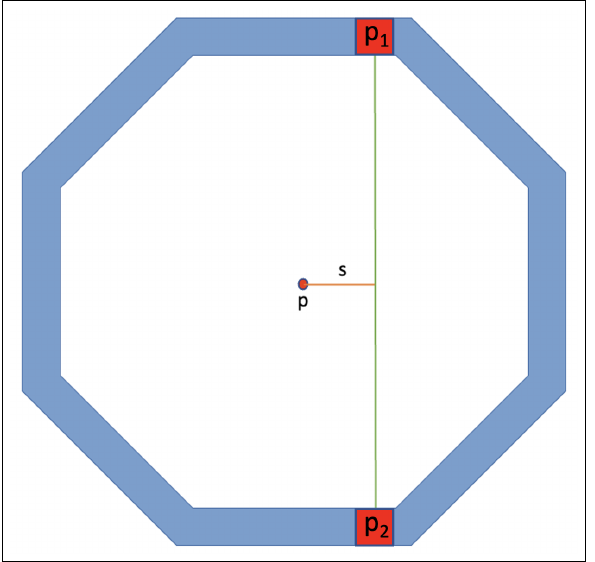
Figure 4. Calculation of s-coordinate using vectors where p is the origin, and p 1 and p 2 are endpoints of LOR. The s-coordinate corresponds to the normal distance from p to LOR (line from p 1 , p 2 ).